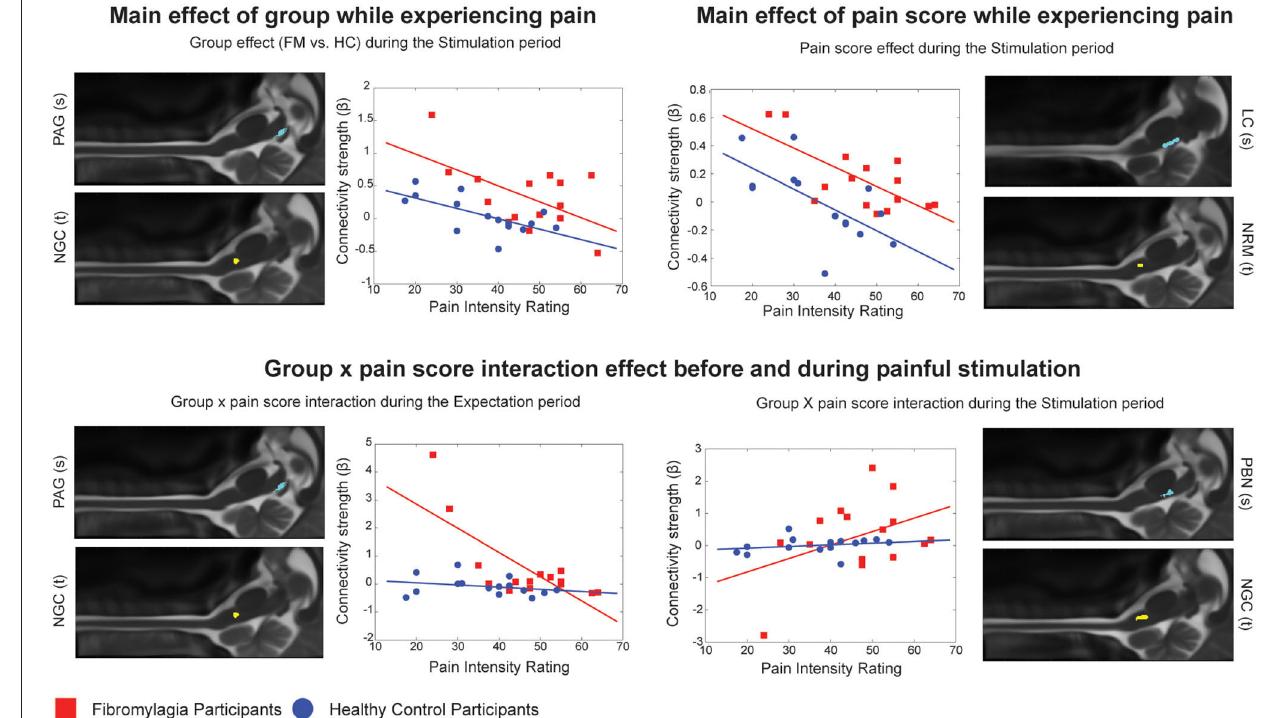
FIGURE 2 | Connection details for 4 example connections obtained from ANCOVA results for both the Expectation and Stimulation periods, comparing main effects of group (FM vs. HC), main effects of normalized pain score, and group x pain score interaction effects. Source regions are denoted with (s) while target regions are denoted with (t). Red points represent individual participants with fibromyalgia while blue points represent the healthy controls. For each figure, the x axis shows the individual average pain intensity ratings for the stimulus while the y axis shows the individual connectivity strengths (calculated and represented as a β